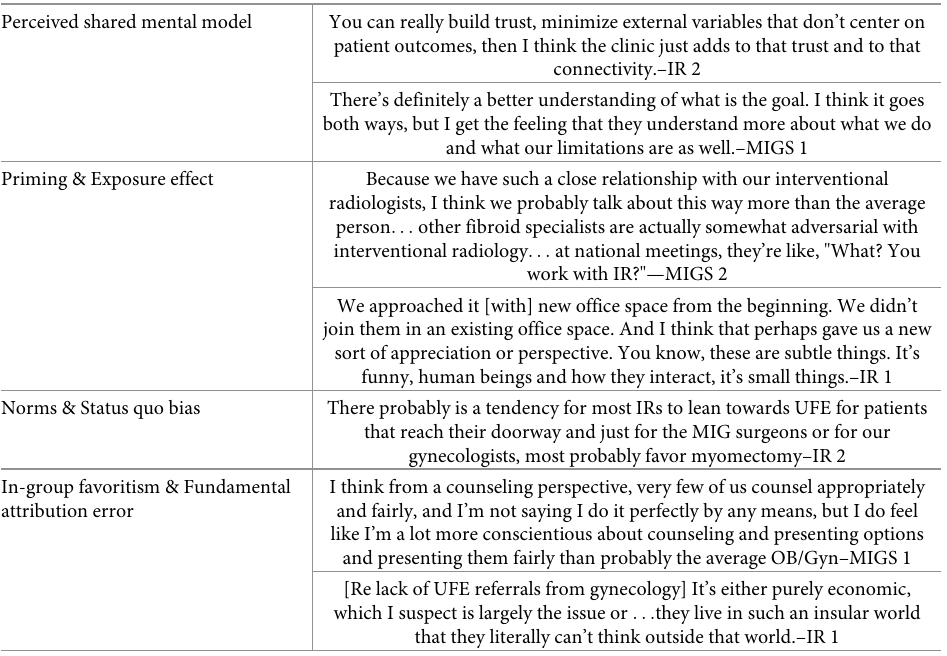
Table 2. Example